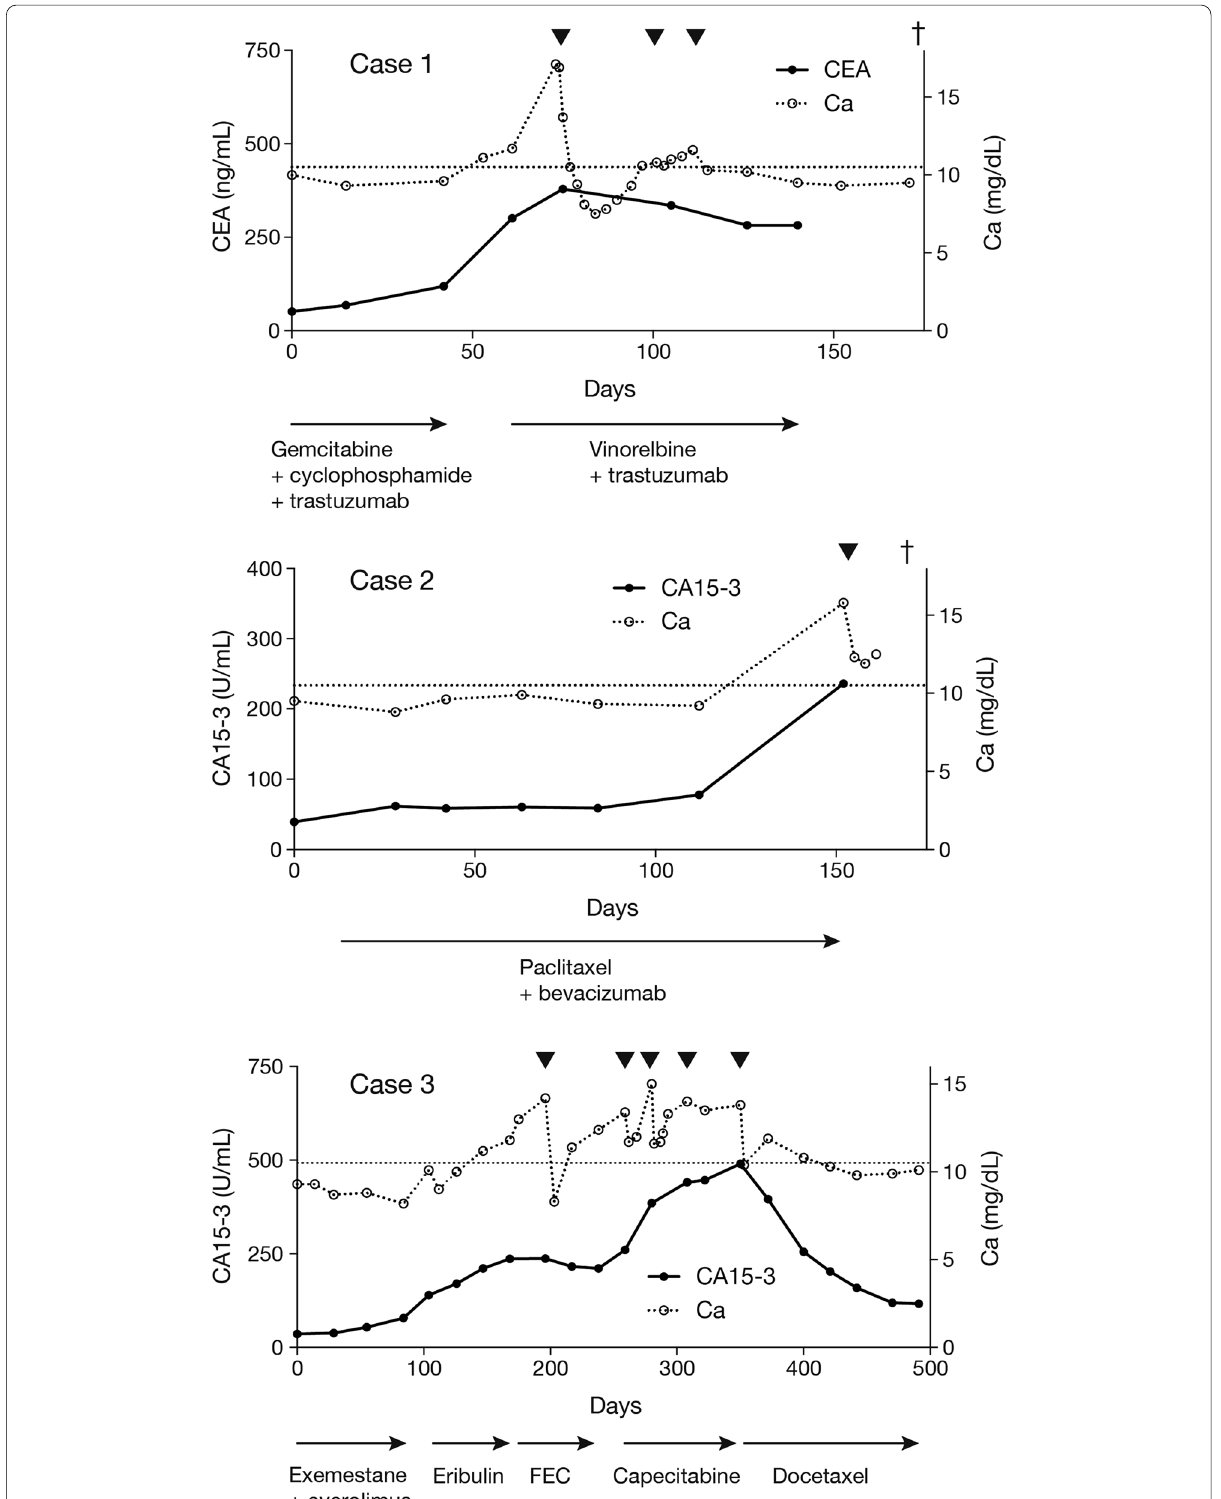
Fig. 1 Time course of serum calcium and CA15-3 levels in Cases 1–3. Black triangles denote administration of zoledronate. A cross represents death. A horizontal broken line indicates the upper limit of serum calcium concentration. FEC fluorouracil